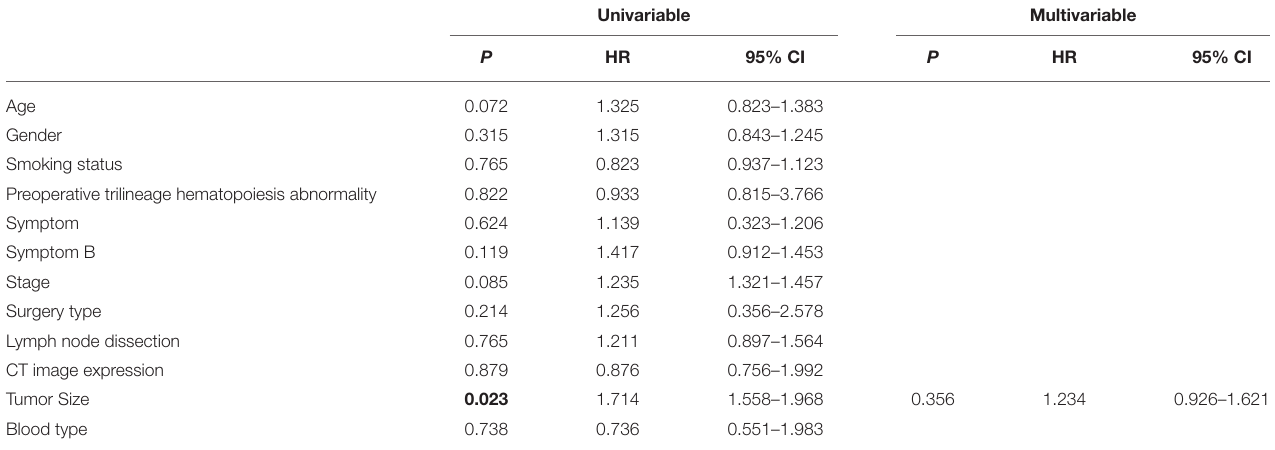
TABLE 3 | Univariable and multivariable analyses for overall survival (OS) in patients with resected primary pulmonary MALT